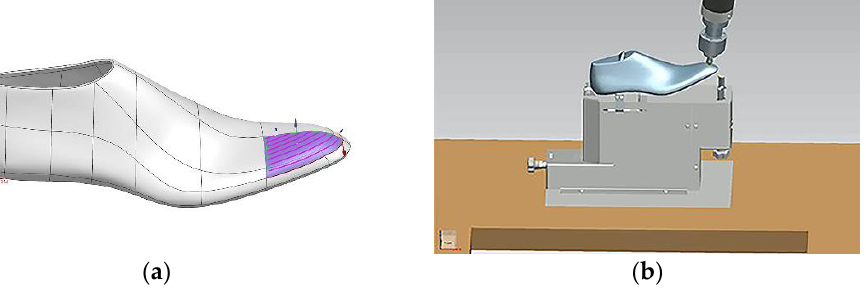
Figure 14. Simulation of the path: ( a ) Trajectory on the shoe surface simulated in NX; ( b ) Simulation of the robot TCP in contact to the shoe surface in Tecnomatix environment.